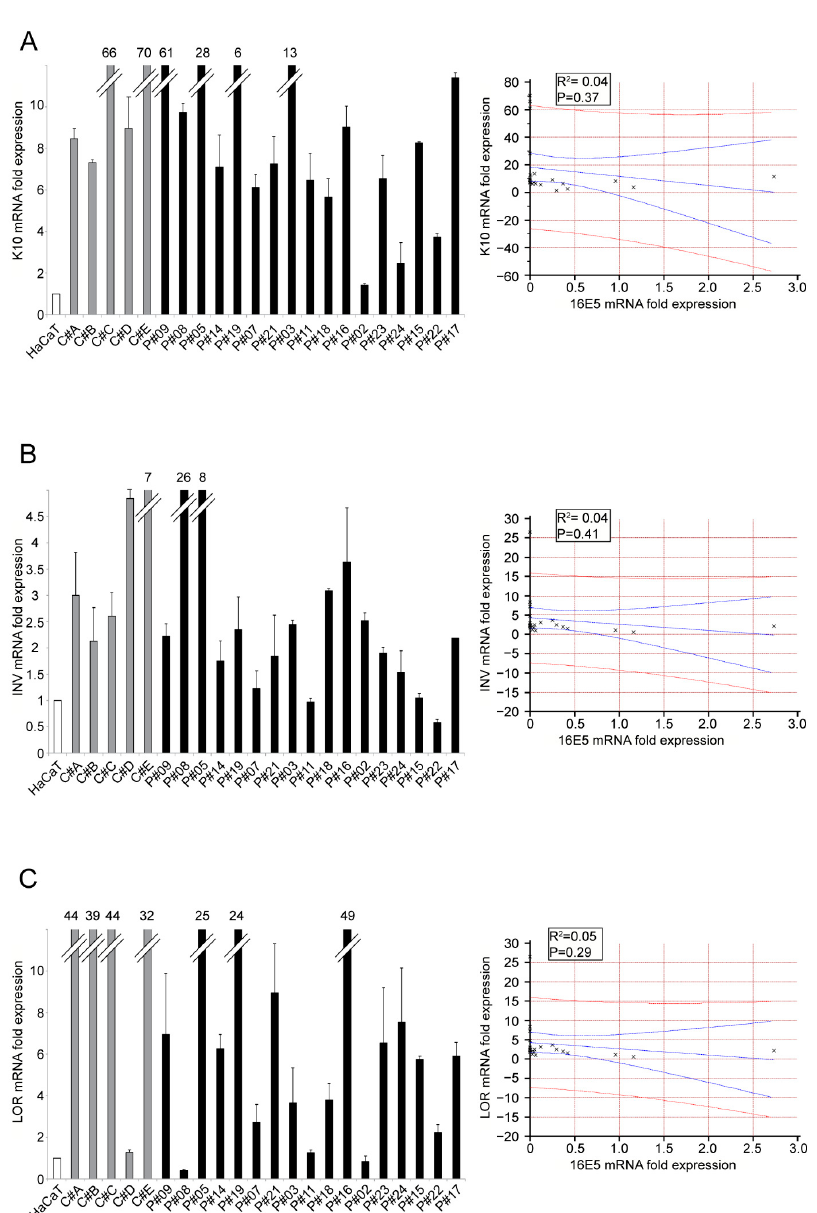
Figure 4. Expression of keratinocyte differentiation markers in LSILs. Keratin 10 (K10) ( A ), involucrin (INV), ( B ) and loricrin (LOR) ( C ) mRNA levels were evaluated by real-time PCR in LSILs and normalized with respect to HaCaT cells. Results are expressed as mean values ± SD. The relationships between the variables are expressed in the scatter diagrams in which HPV16E5 expression levels are plotted on the horizontal axis and the Keratin 10, involucrin and loricrin expression levels are plotted on the vertical axis. The regression line ± 95% confidence limits are shown in blue, and the ± 95% prediction bands are in red. R 2 : Pearson’s correlation coefficient